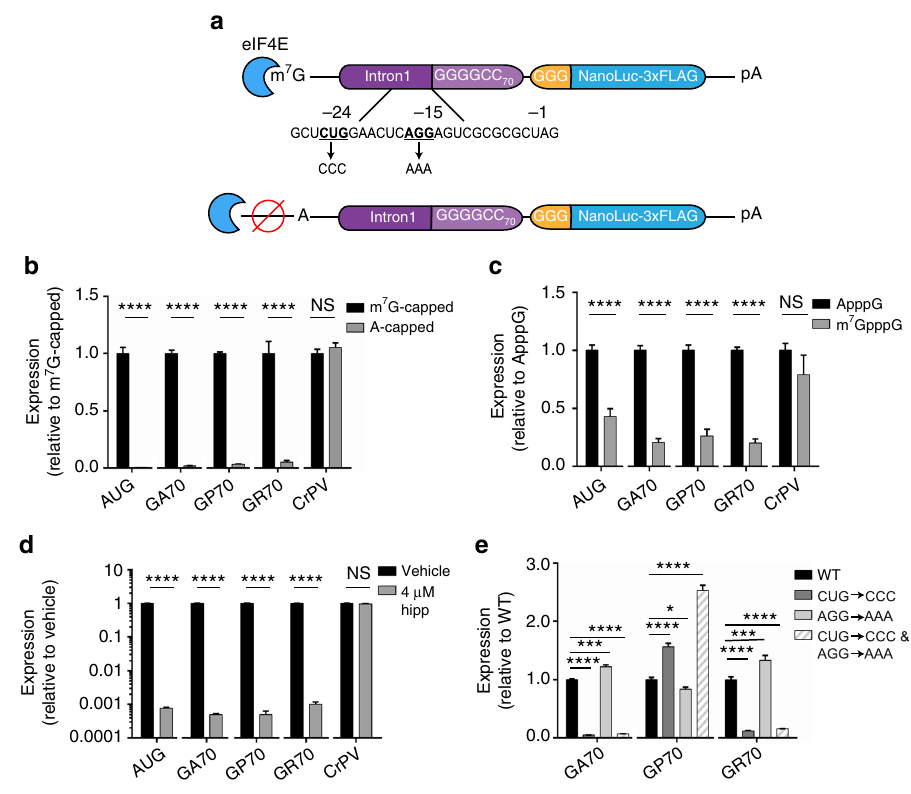
Fig. 2 C9RAN is cap- and eIF4A-dependent and can initiate at a near-cognate start codon. a Schematic of 5 ′ -cap C9RAN reporter mRNAs and near- cognate start codon mutations. b Expression of m 7 G-capped and A-capped control and C9RAN reporters in RRL, n = 6. c Expression of control and C9RAN reporters in RRL when excess free m 7 G (250 μ M) or equimolar A-cap was added to inhibit eIF4E in trans , n = 6. d Expression of reporter mRNAs when eIF4A, the canonical helicase required for ribosome scanning during initiation, is inhibited with 4 μ M hippuristanol (hipp), n = 6. e Mutational analysis of near-cognate start codons upstream of the repeat in the GA frame as depicted in a , n = 6. Graphs represent mean ± SEM. Two-tailed Student ’ s t test with Bonferroni and Welch ’ s correction, ∗ p < 0.05; ∗∗∗ p < 0.001; ∗∗∗∗ p < 0.0001. GA glycine – alanine, GP glycine – proline, GR glycine – arginine, CrPV cricket paralysis